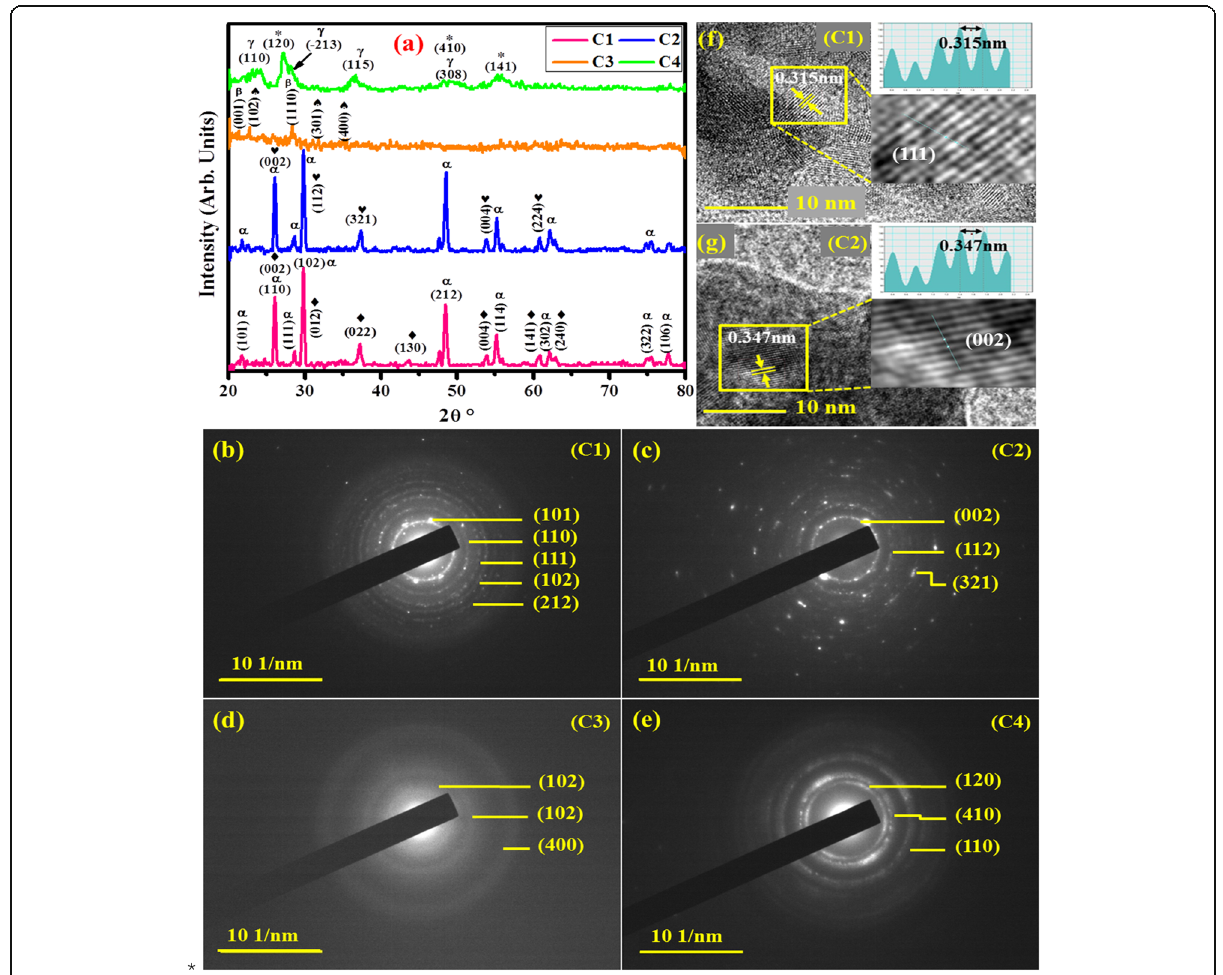
Fig. 3 a XRD patterns. b-e SAED images of C1, C2, C3, and C4 samples (550 ° C) for 48 h. f-g HRTEM micrograph of nanocrystals (C1 & C2) showing lattice-fringed